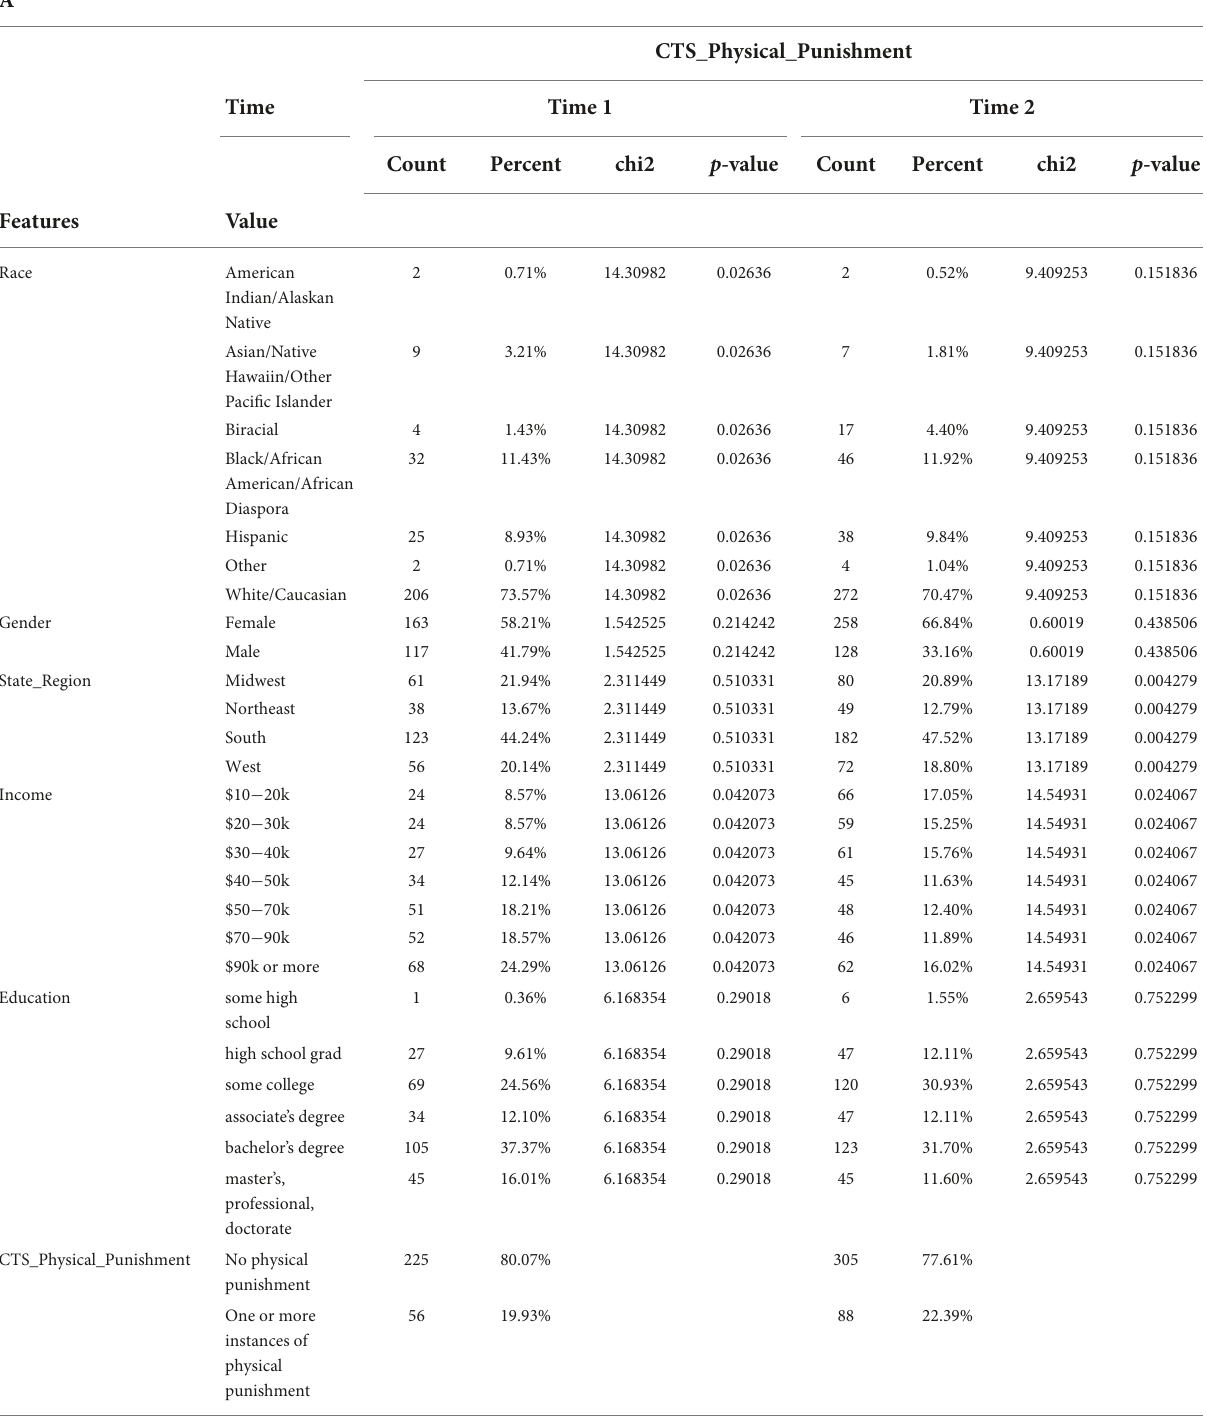
TABLE 6 Descriptive data for Times 1 and